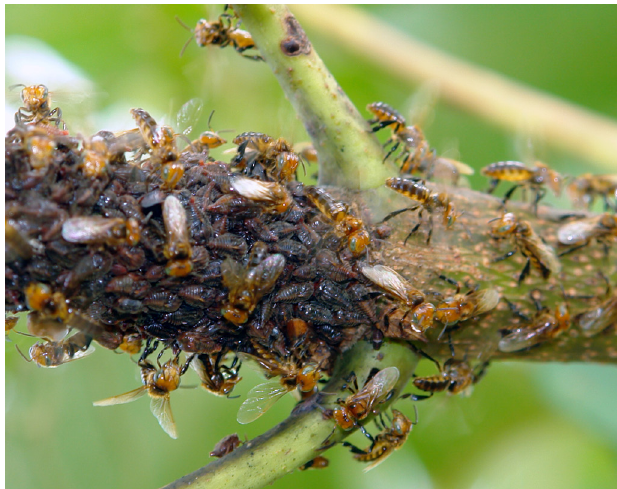
Fig 2 . Agonistic behavior displayed by Oxytrigona tataira (Smith) (Hymenoptera: Apidae: Meliponini) as a result of feeling threatened by the presence of the